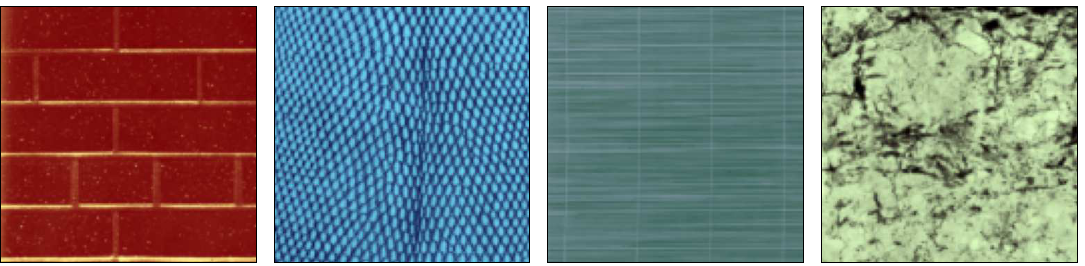
Figure 3. Texture images from the Brodatz dataset [82].